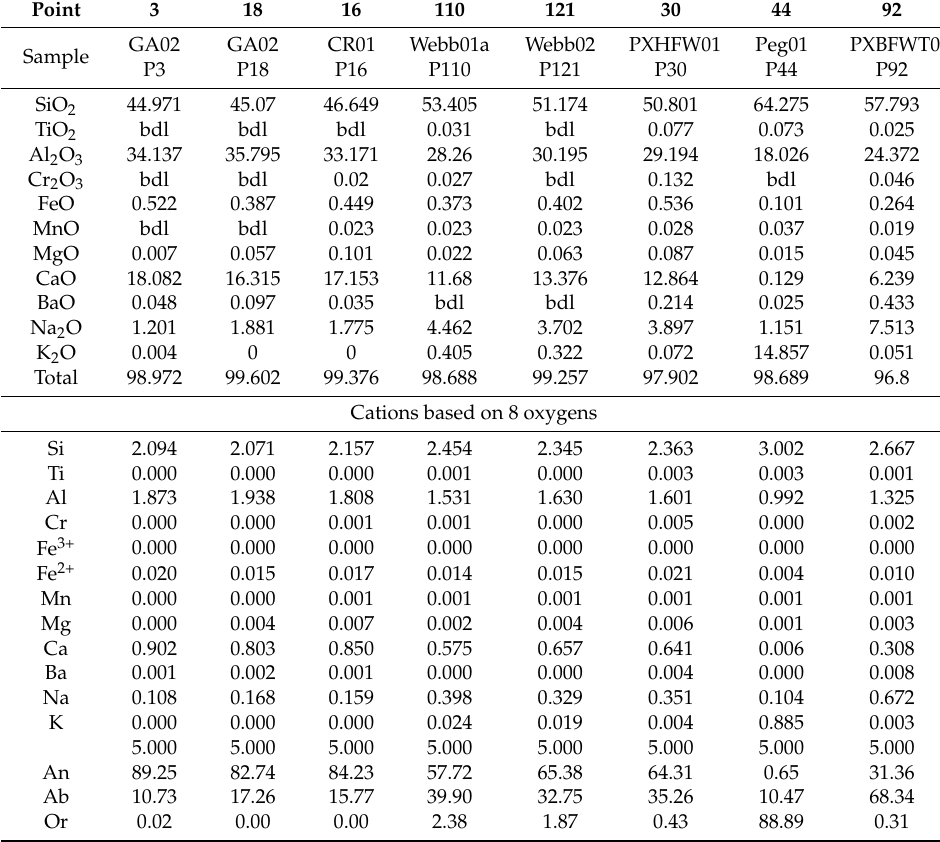
Table 5. Representative feldspar analyses in wt